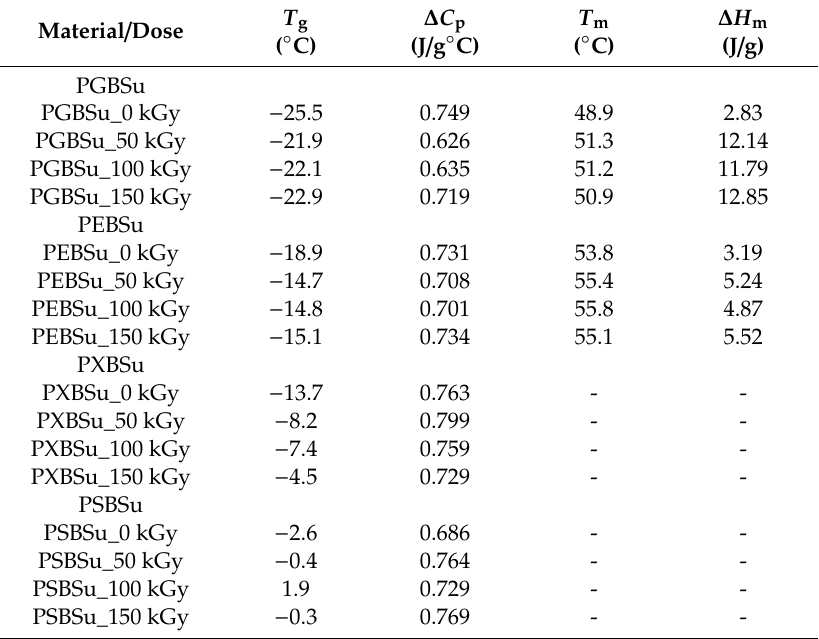
Table 3. First-heating data for di ff erential scanning calorimetry (DSC) analysis of non-irradiated and radiation-modified poly(glycerol succinate-co-butylene succinate) (PGBSu), poly(erythritol succinate-co-butylene succinate) (PEBSu), poly(xylitol succinate-co-butylene succinate) (PXBSu), and poly(sorbitol succinate-co-butylene succinate)